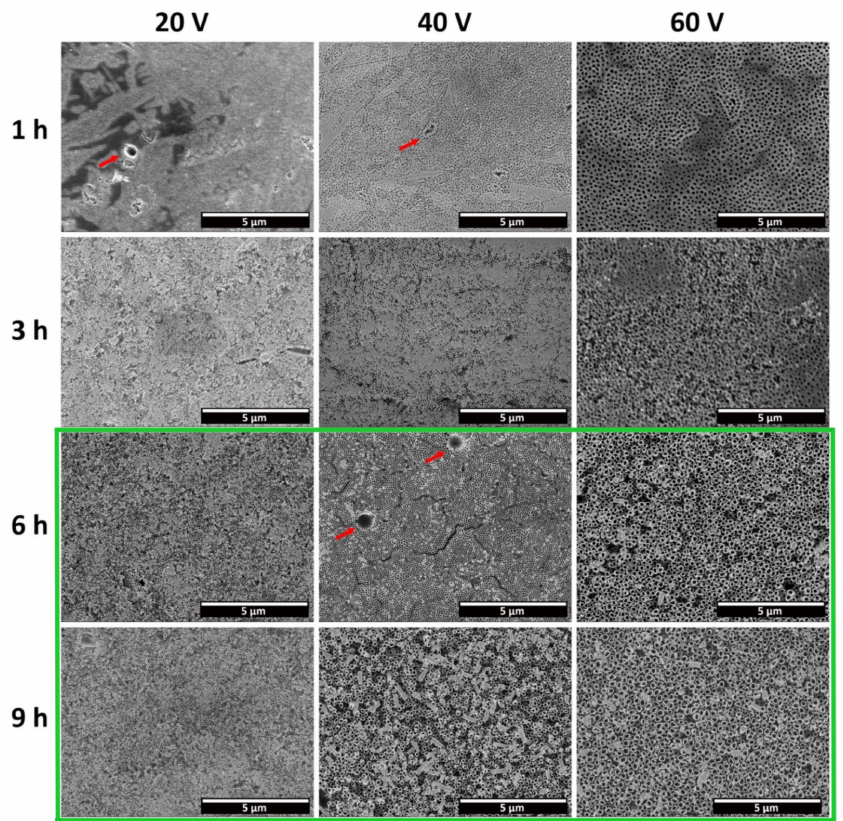
Figure 5. FESEM micrographs depicting a top view of the anodic oxide layer produced through electrochemical anodization in a CP-Ti substrate, at different applied potentials and times. The green frame highlights the conditions in which open-top nanotubes can be distinguished. The red arrows indicate cavities present on the